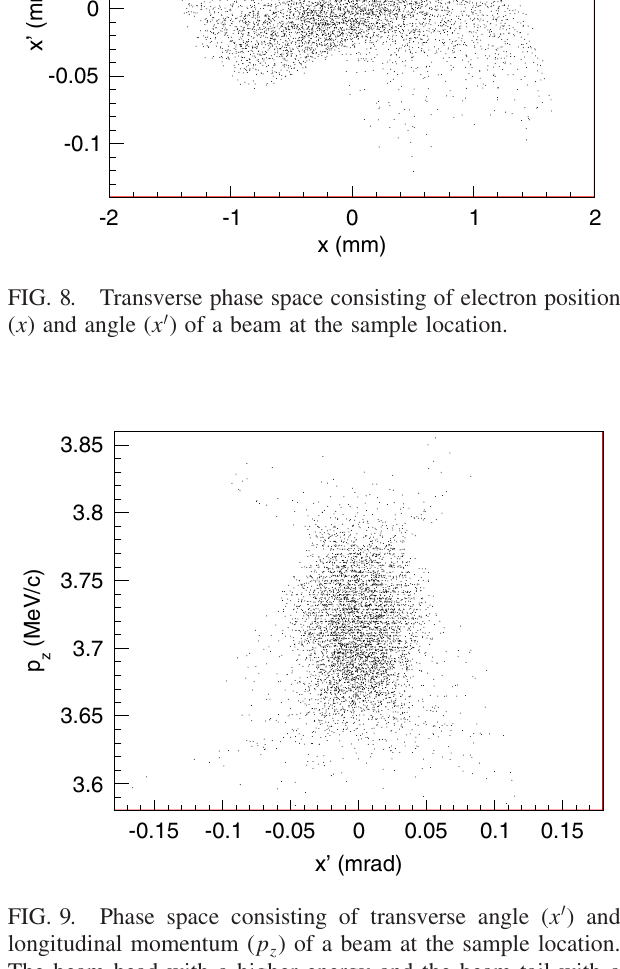
FIG. 11. Normalized rms slice emittance. At the central slices where most of electrons are populated, the slice emittance is about 0.1 mm mrad.